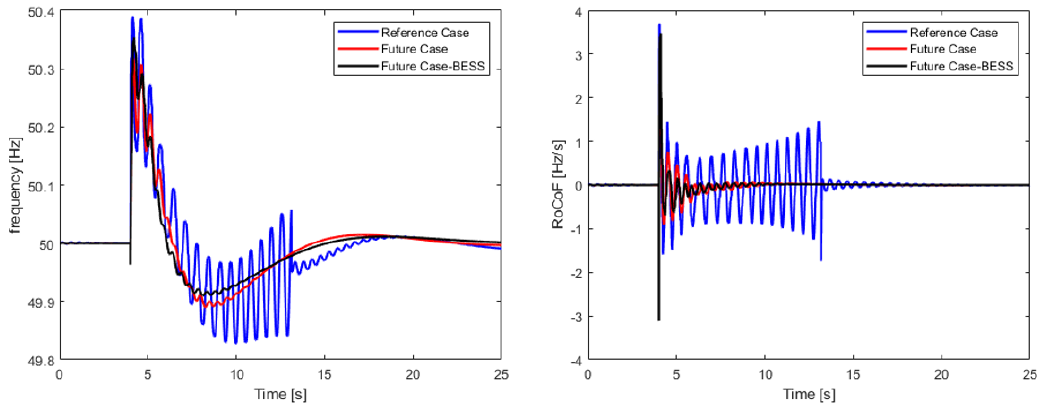
Figure 16. Short-circuit frequency response and RoCoF for the best cases of the reference, future and future with BESS scenarios.